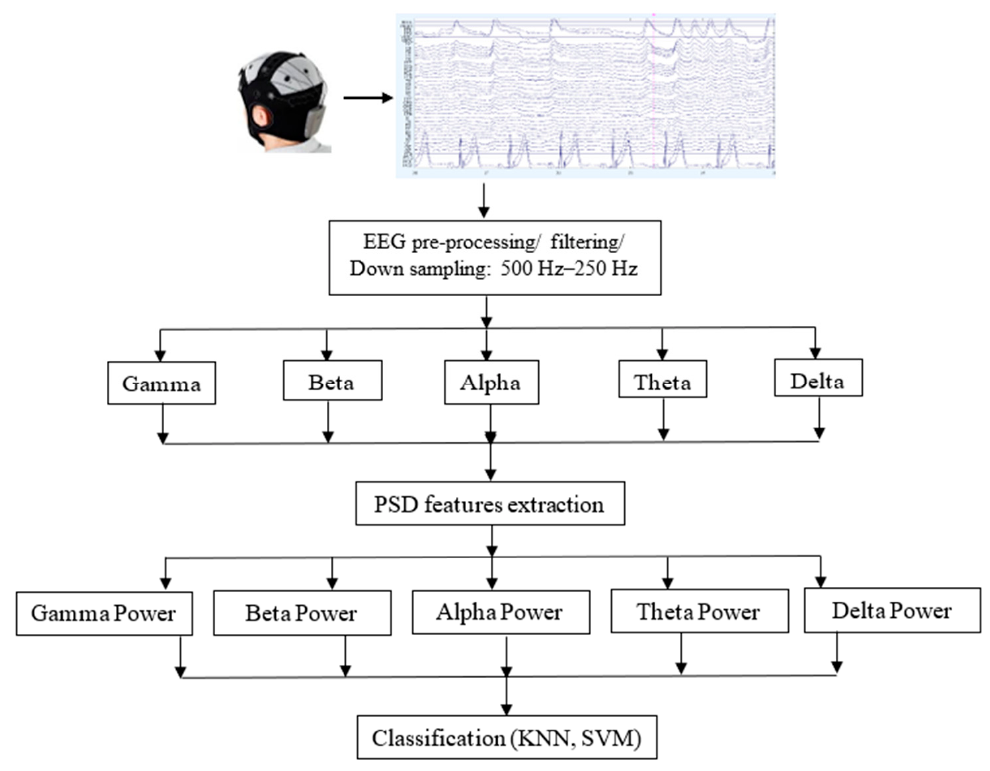
Figure 3. General framework.